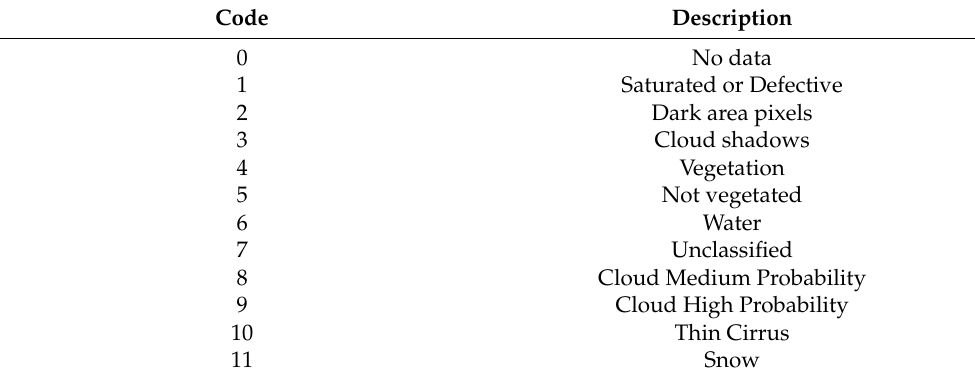
Table 3. Coding of pixel assignment classes adopted in the “scene_classification” layer provided with Level 2A products.